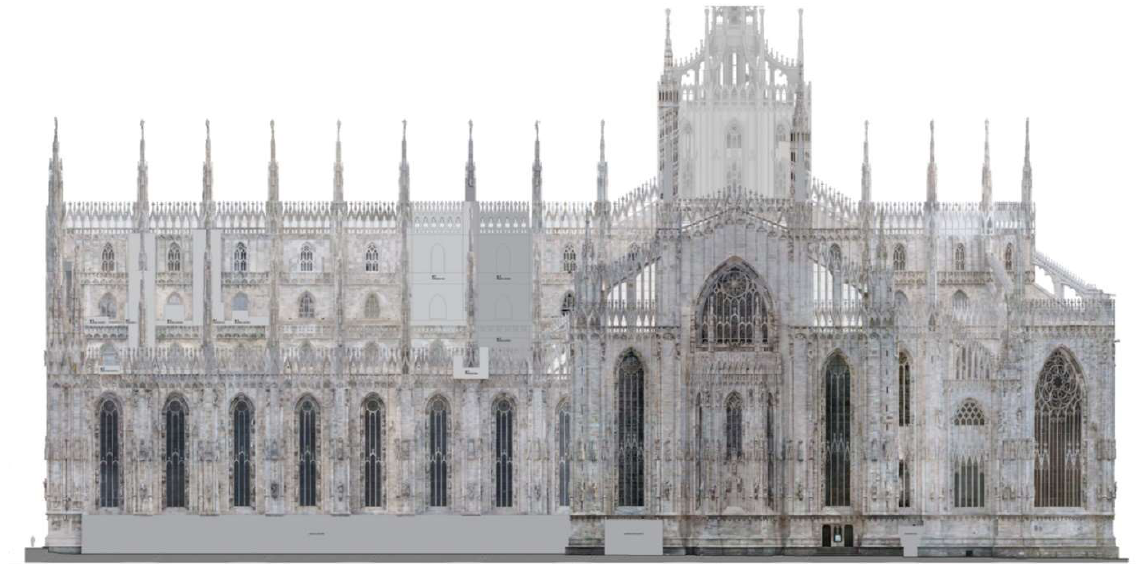
Figure 9. Ortophoto of the South façade: 7586 images, around 1.9 billion pixels (GSD 2mm), 156m long.